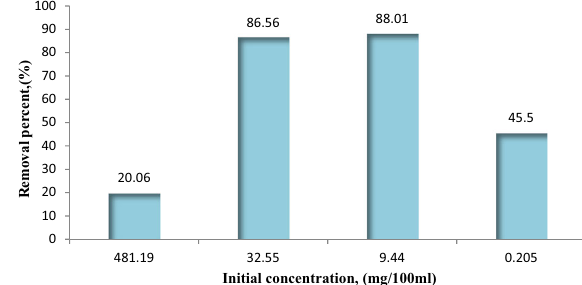
Fig. 3 Effect of initial Fe + 3 concentration (0.203 – 481.19 mg/ 100 mL) on the removal percentage of iron III by using 4 g/ 100 ml of A. niger as bioadsorbent at the solution pH 2.4 at room temperature and for a contact time 60 min. n = 3